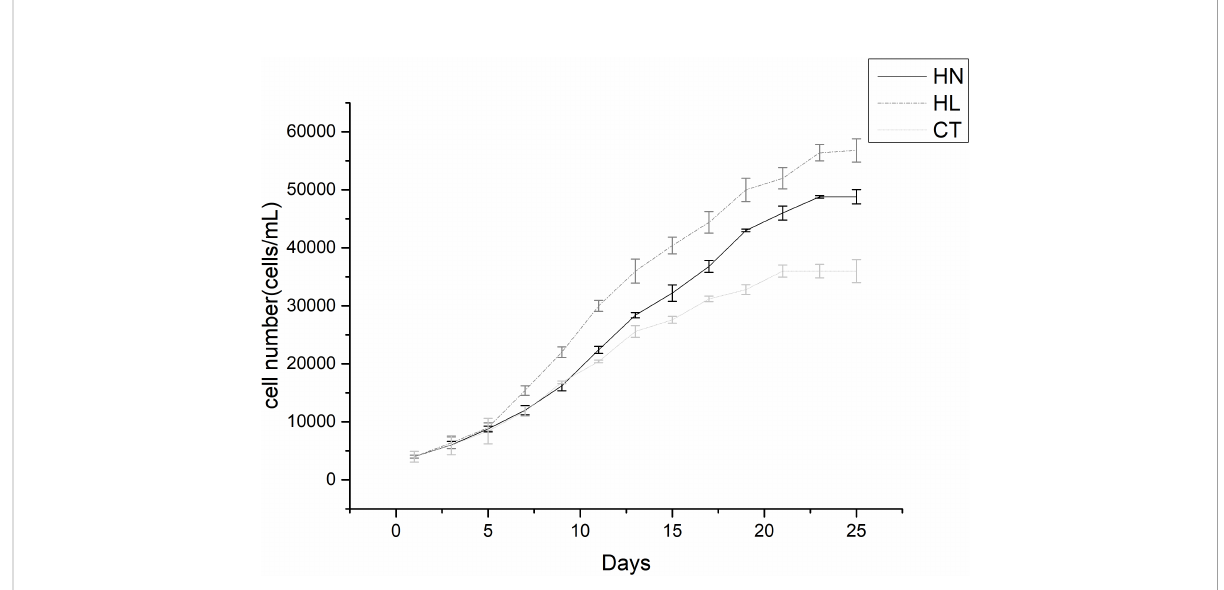
FIGURE 1 Growth curves of Alexandrium paci fi cum under different conditions. High light (HL), high nitrogen (HN), and f/2 normal medium condition (control [CT]). Each point is the mean of three independent experiments.